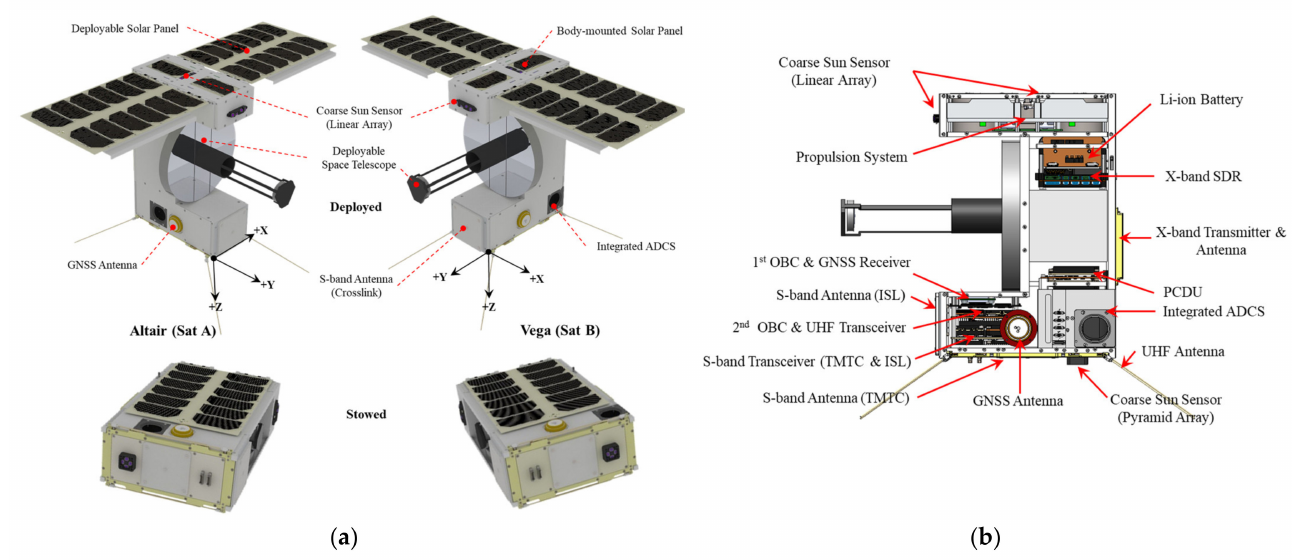
Figure 14. Configurations and body reference frame coordinates of nanosatellites: ( a ) stowed and deployed exterior configurations of the Altair and Vega; ( b ) interior configurations of the Vega. The